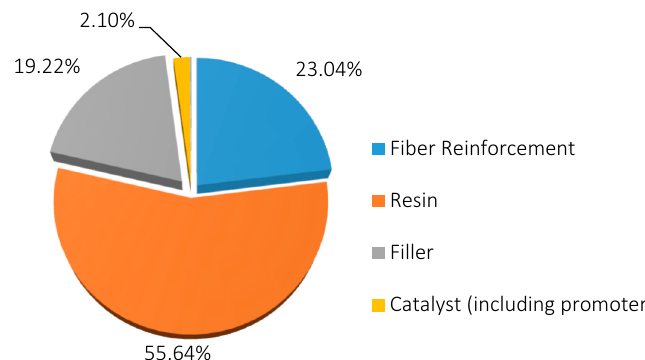
Figure 3. Volume fraction of material composition.